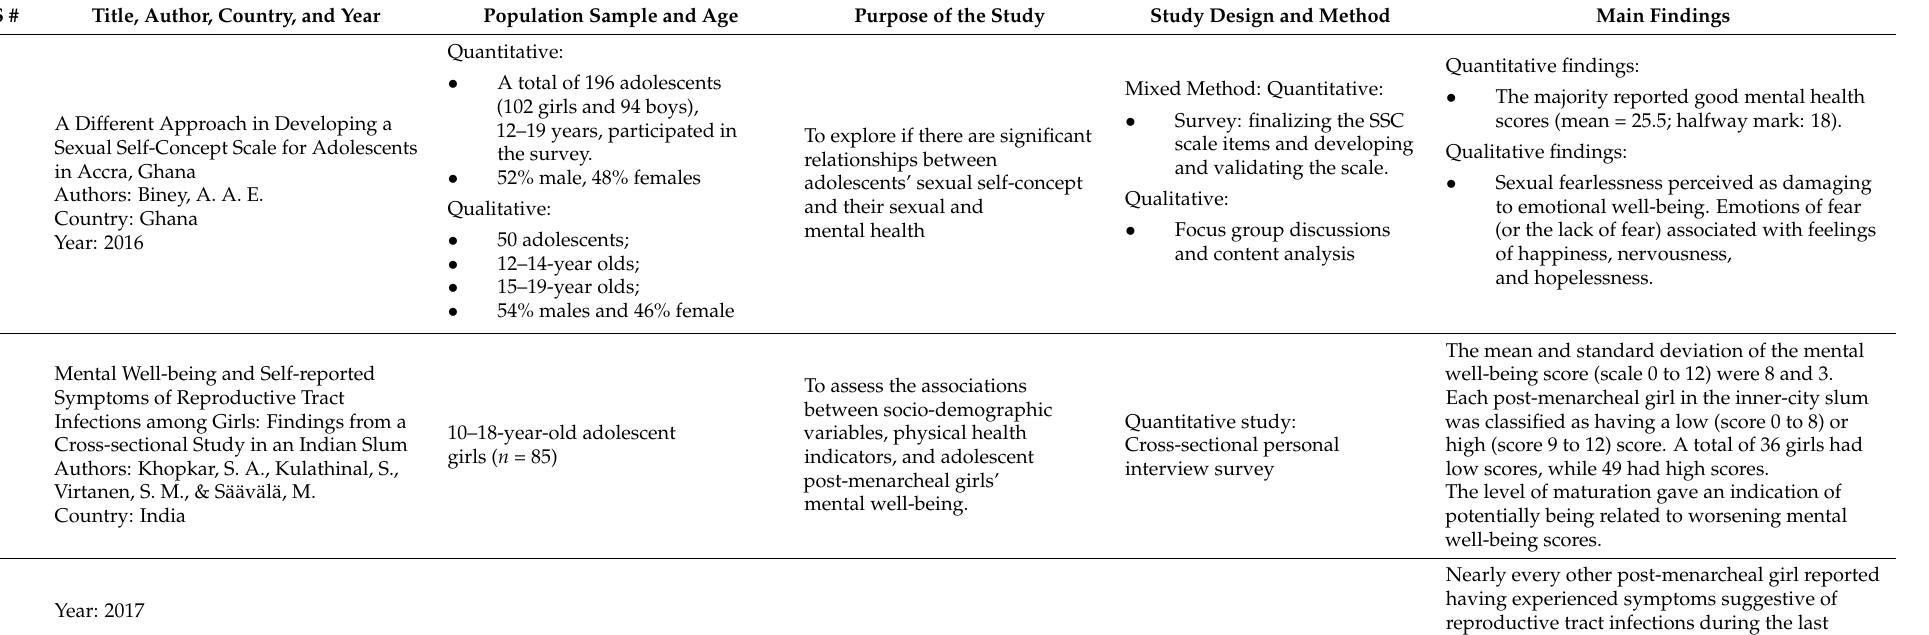
Table A1. Scoping Review: Summary of the 12 Studies